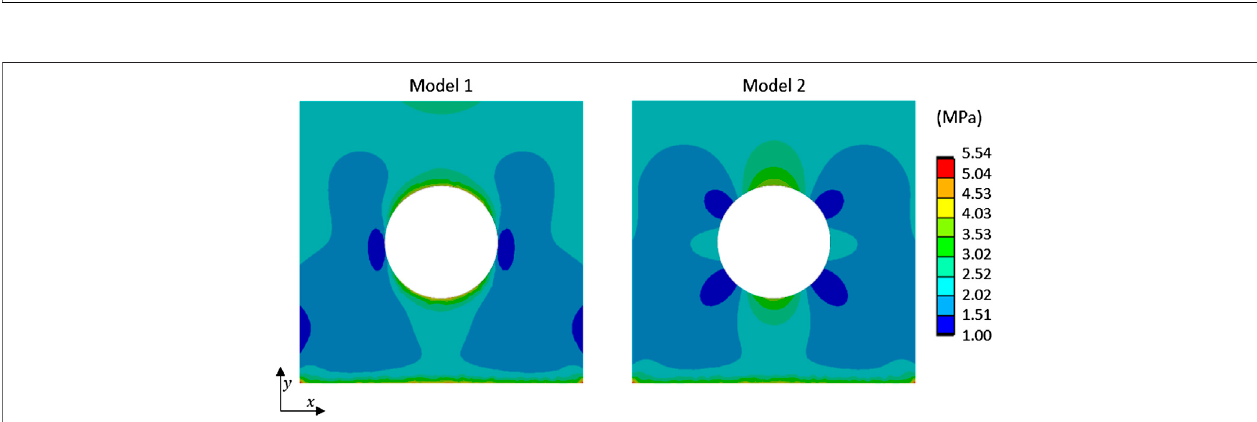
FIGURE10| Equivalentstress fi eldsfromFEsimulationofcompressiontestfortwomodels(Model1:cementandcancellousbonewerebonded;Model2:cement and cancellous bone were not bonded without separation) and loading of 500 N.